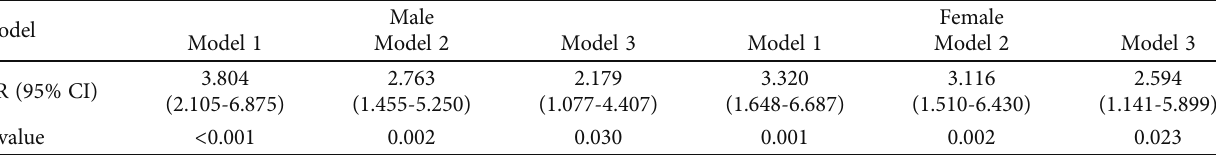
Table 2: The correlation between ALT/AST and low muscle mass.